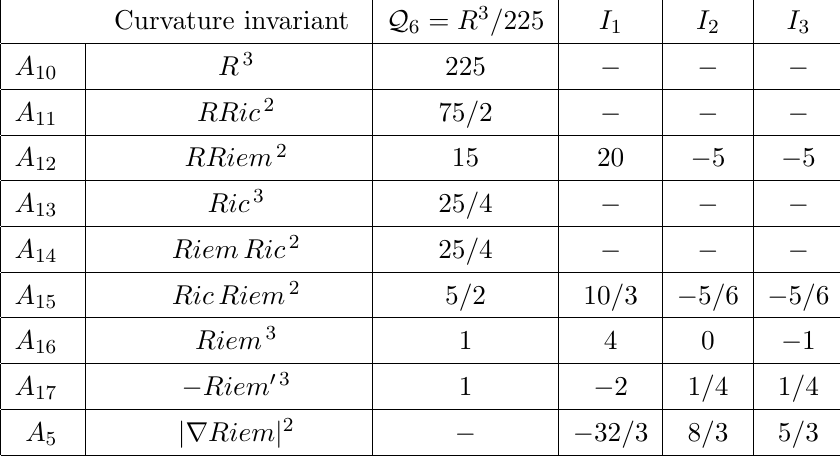
Table 1 . Ricci and Weyl content of 6D curvature